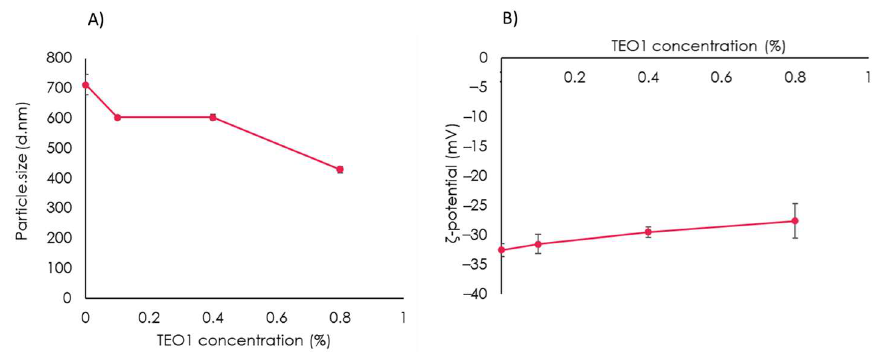
Figure 2. Particle size and zeta potential of WP-based FFSs prepared in the presence of different concentrations of TEO1 (v/v). Values are the mean ± SD. ( A ) particle size, ( B ) zeta potential. To determine the ability of WP-containing FFSs to inhibit microbial growth, MIC 100 values were calculated by carrying out dose-response experiments. WP FFSs prepared in the absence of TEO1 showed a slight antimicrobial activity towards all the strains tested. Conversely, the FFSs containing the lowest concentration tested (0.1%) of TEO1 were able to totally suppress the bacterial growth in the case of the gram-negative bacteria S. enteriditis 706 RIVM, S. enterica subsp. enterica serovar Typhimurium (ATCC ® 14028) and the gram-positive S. aureus ATCC 29213 (Figure 3A–C, respectively). Moreover, in the case of E. faecalis ATCC 29212, FFS containing 0.1% TEO was found to inhibit the bacterial growth by about 50%, whereas complete inhibition was observed in the presence of 0.4% TEO1 (Figure 3D).